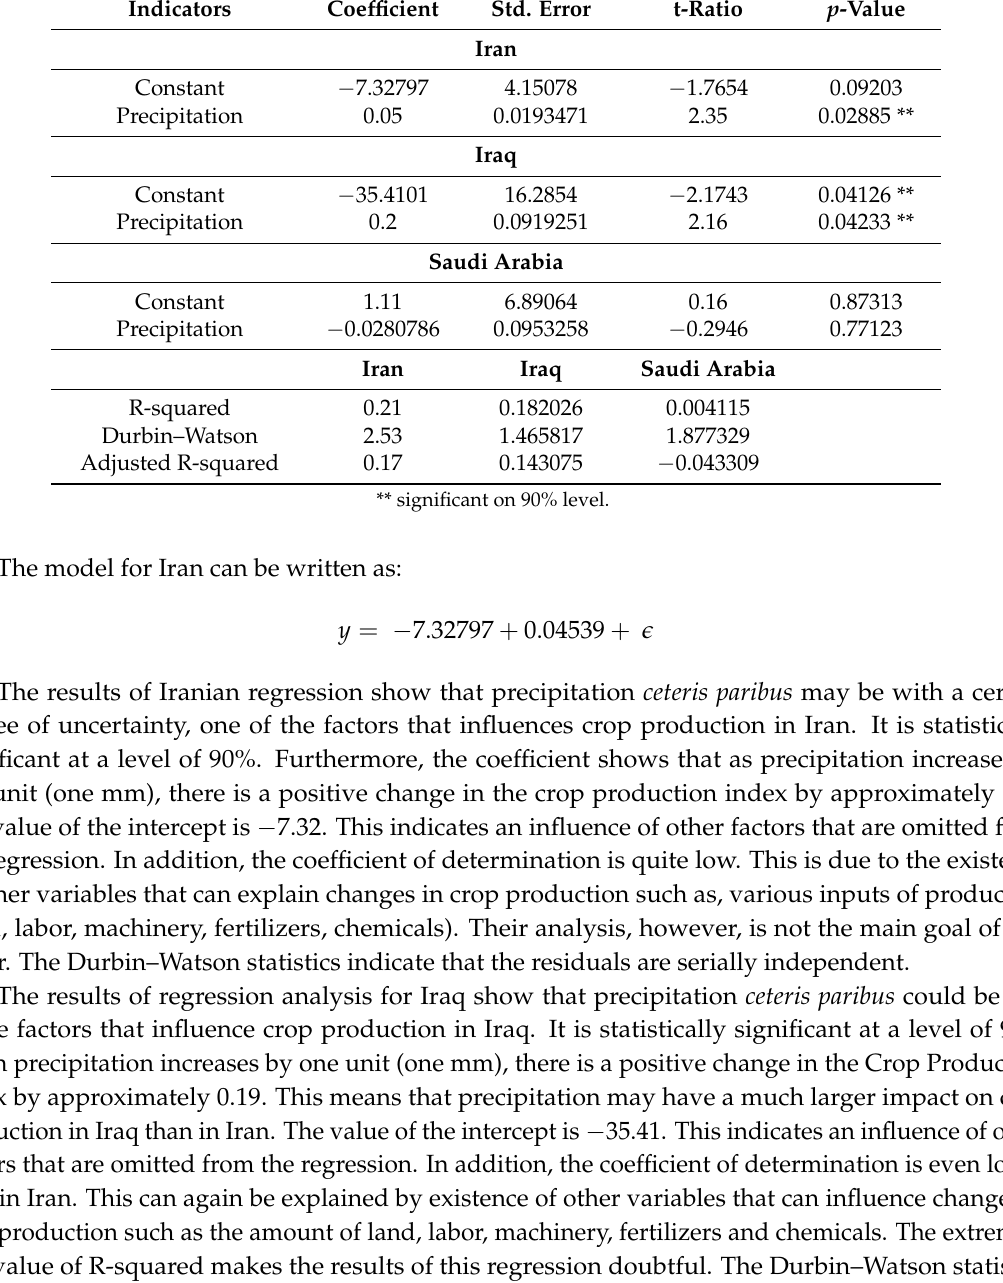
Table 3. Regression results (Iran, Iraq, Saudi Arabia) using observations 1993–2015 (n = 23). Indicators Coefficient Std.